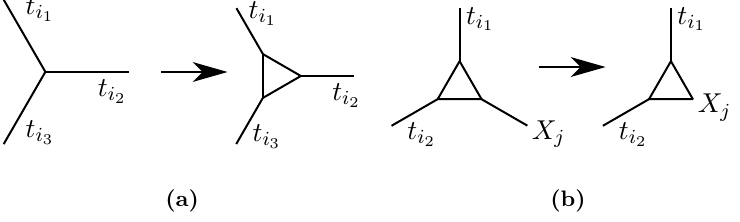
Figure 4. b (cid:0) is obtained from (cid:0) by (cid:12)rst blowing up all the cubic vertices into triangles ((cid:12)gure 4a) and then deleting any external edges but reusing their labels ((cid:12)gure